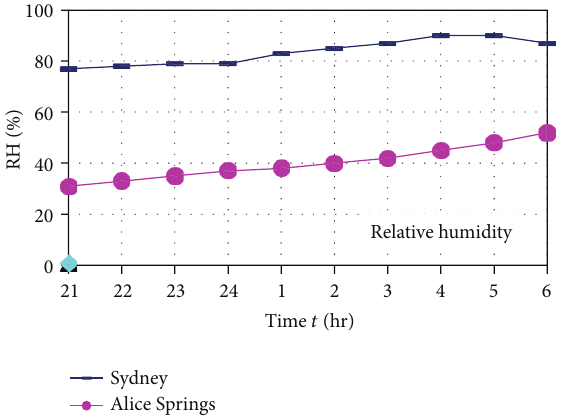
Figure 6: Relative humidity rate in the two locations.